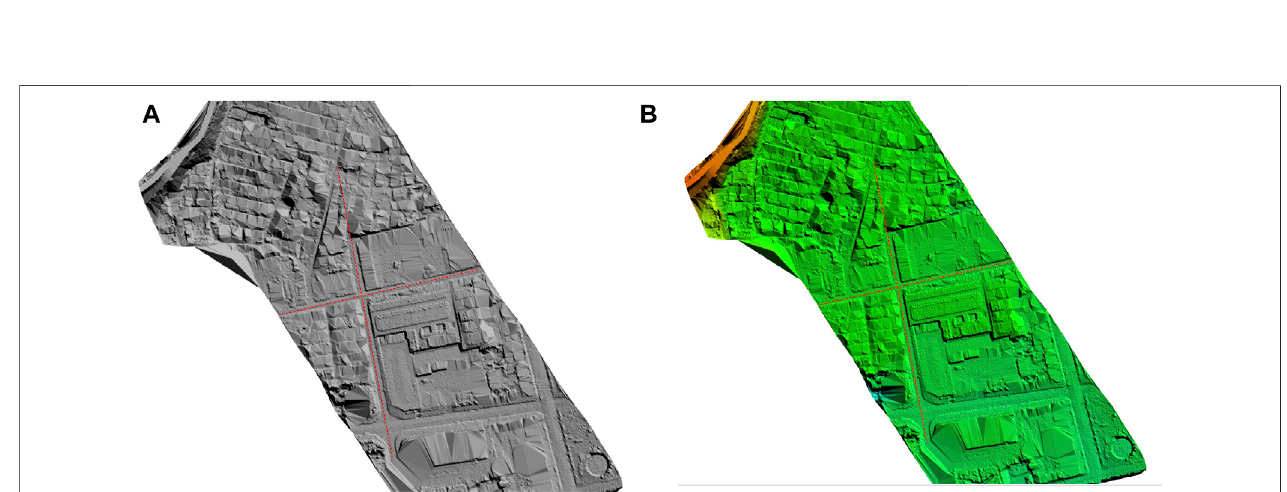
FIGURE 13 | DEM fromed by the processed point cloud. (A) DEM of Phase I; (B) DEM of Phase II.